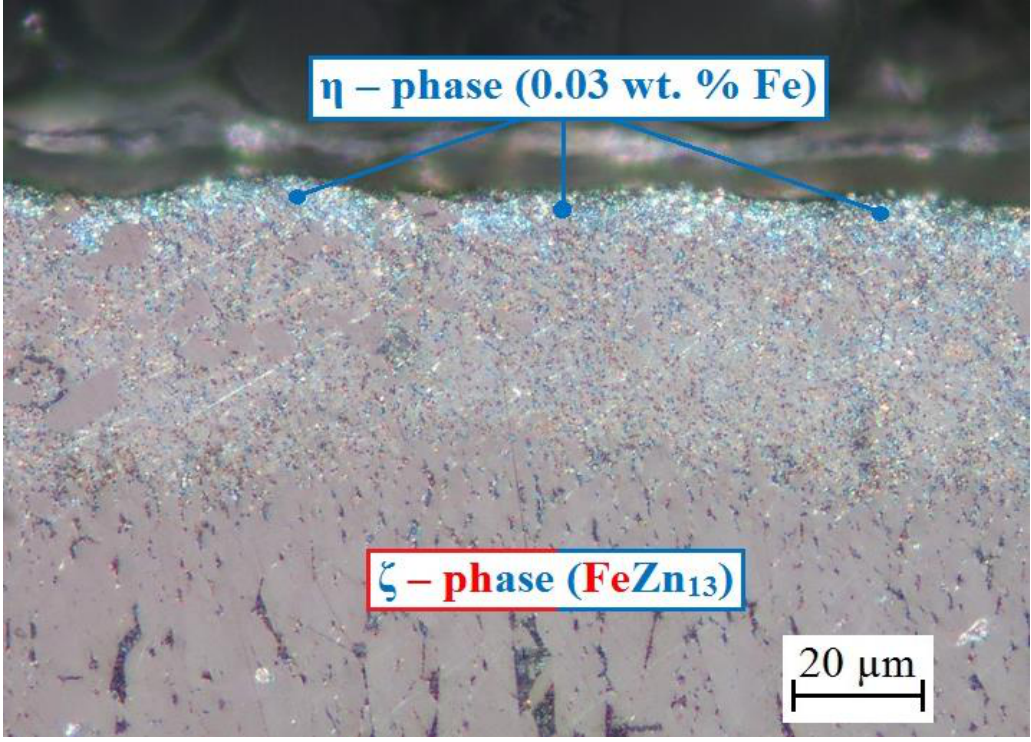
Figure 3. Cross cut of HDG zinc coating on flat steel sheets — detail view of the outer layer.